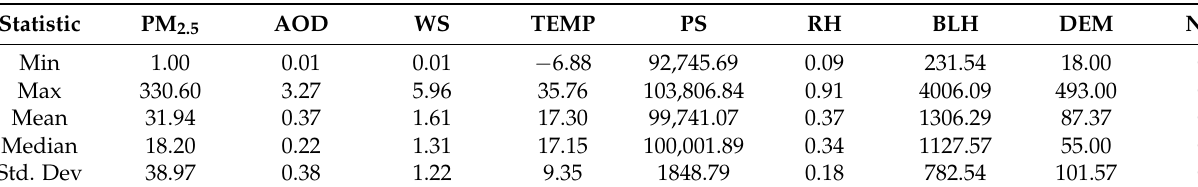
Table 4. Descriptive statistics of the data used in the AutoELM modeling.